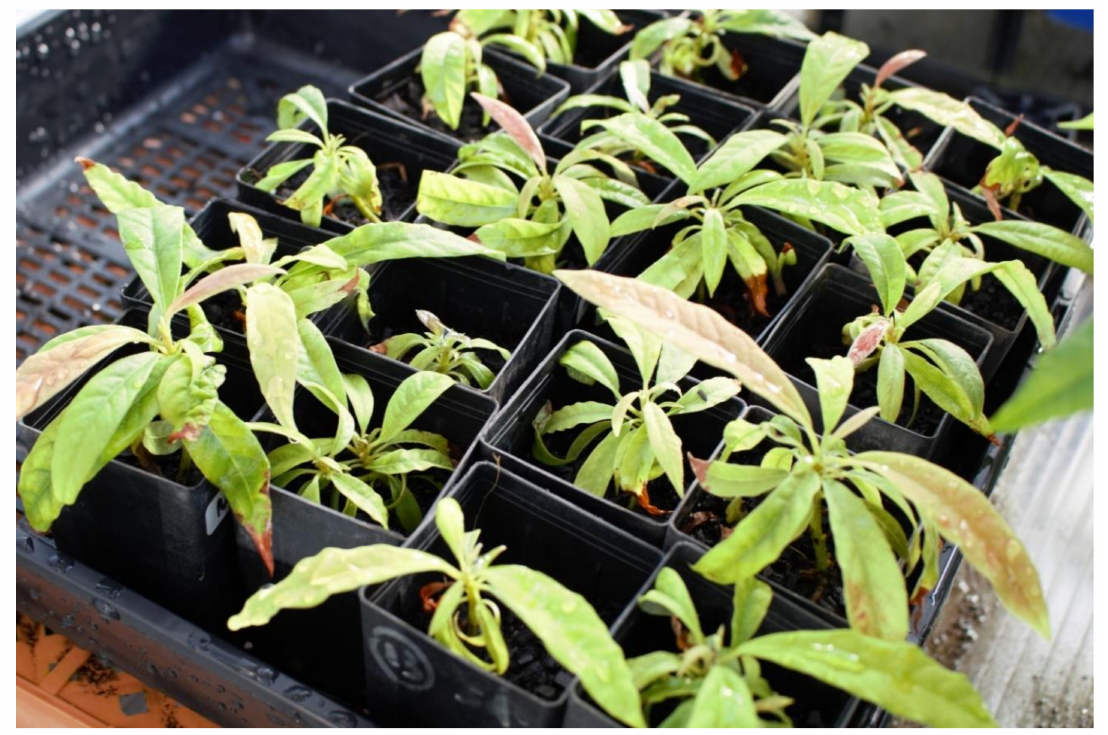
Figure 2. Shoot tips of cv ‘Reed’ treated with VSL and revived from LN growing in a